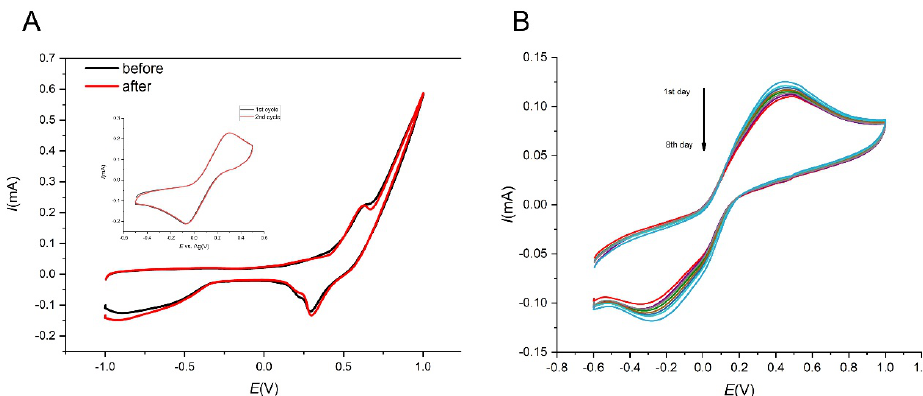
Figure 13. Cyclic voltammograms for 10 µ M insulin in 0.1 M NaOH before and after cycling. Inset: Cyclic voltammograms to measure the stability in 5 mM K 3 [Fe(CN) 6 ] for 30 cycles ( A ). Cyclic voltammograms for 5 mM K 3 [Fe(CN) 6 obtained at 1st to 8th day of storage ( B ).